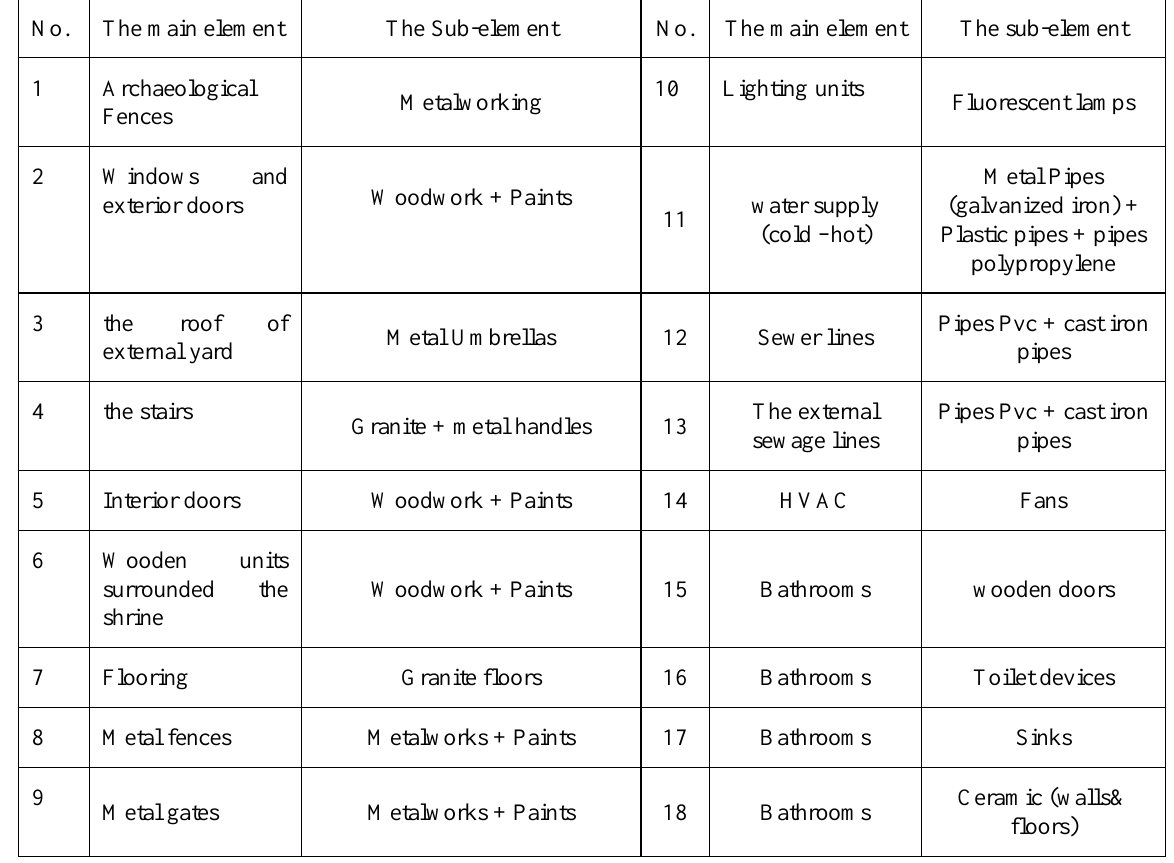
Table 2. elements and components of Abul-Hajjaj